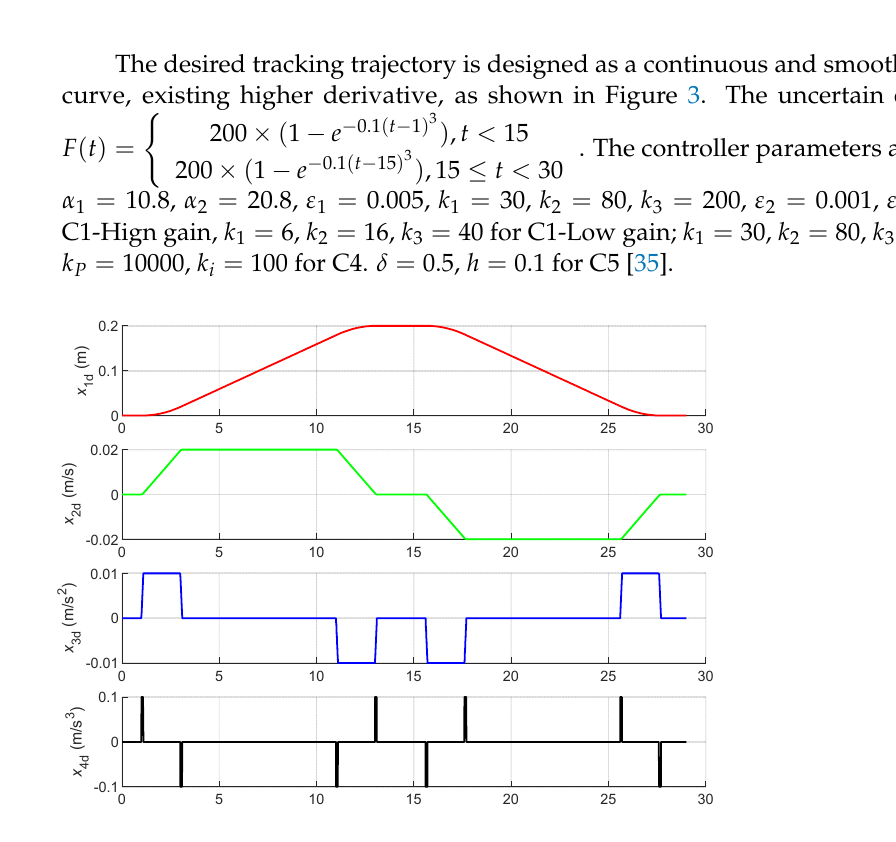
Figure 3. Desired tracking trajectory of EHA completion of an extension and retract.